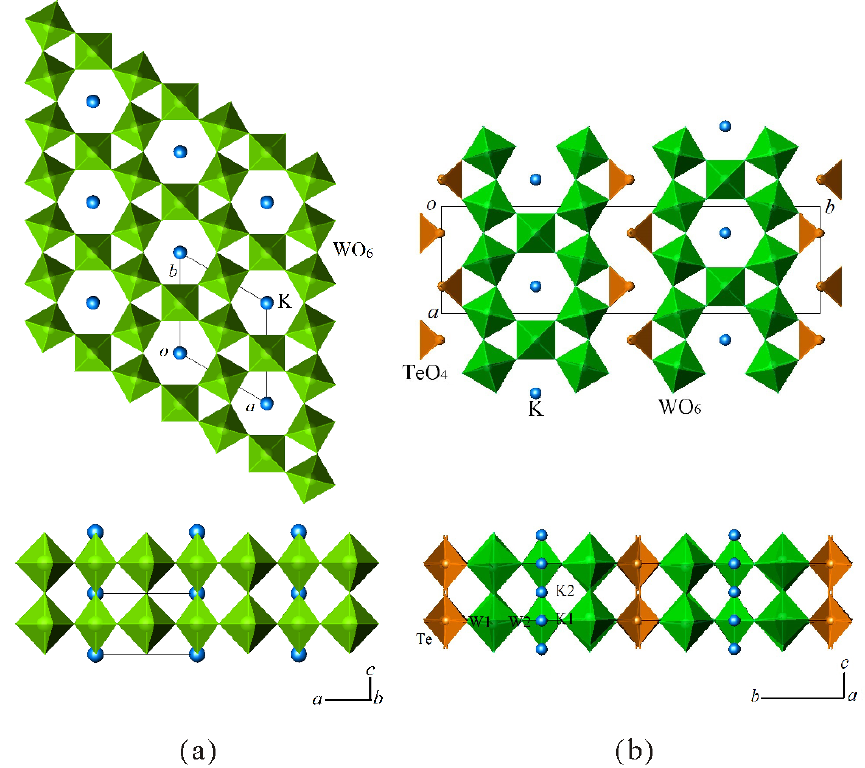
Figure 7. Comparison of the structures of (a) wumuite and (b)